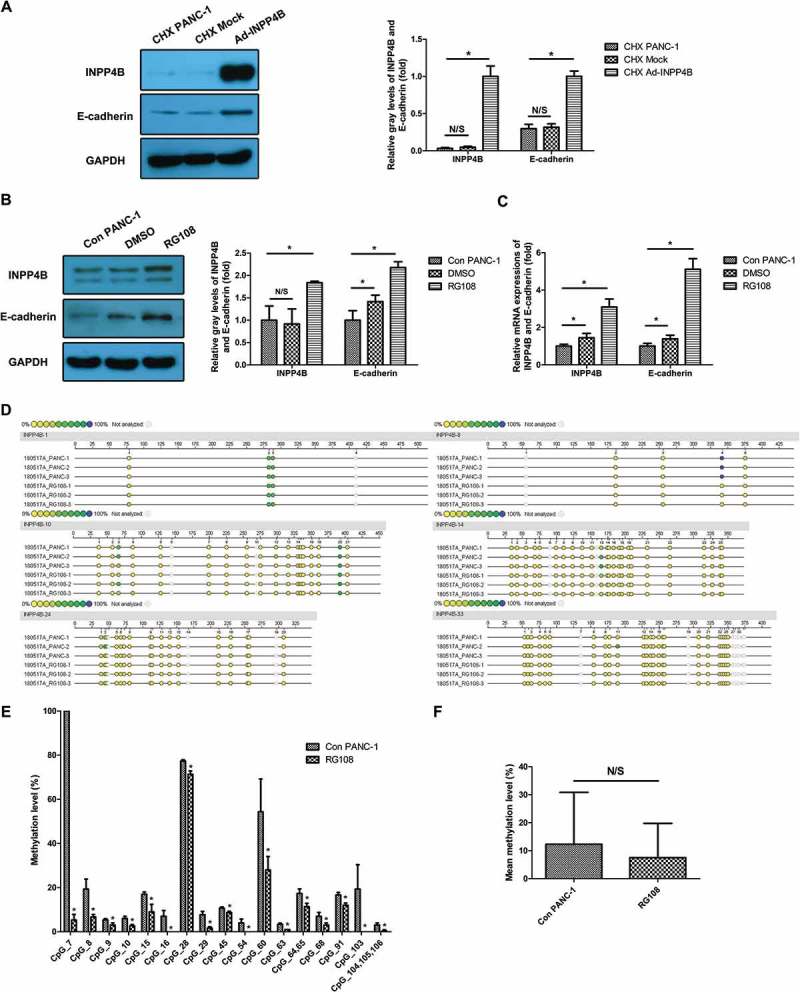
Chemicals treatment of PANC-1(a) PANC-1 cells overexpressing INPP4B were incubated in RPMI containing CHX and lysed for western blotting detection of Ecad and INPP4B. Mock infected and uninfected cells were parallelly treated with CHX and served as controls. (b, c) PANC-1 cells infected by Ad-INPP4B were treated with RG108 and probed for Ecad and INPP4B by western blot and RT-qPCR. DMSO-treated and untreated cells served as controls. The quantitative results of western blot and PCR were analyzed basing on gray-level ratio of target band and 2-△△Ct method. GAPDH was used as housekeeping gene for all data normalization. (d) Sequenom MassARRAY platform was used for the quantitative methylation analysis. The colors of each circle represent the methylation level of each corresponding CpG unit. Quantitative methylation analysis results are shown in a color scale: yellow (0% methylation), green (50% methylation), and dark blue (100% methylation). The white circles represent the missing data at a given CpG site. (e) The significantly changed methylation levels of certain CpG units were shown. (f) Mean methylation percentage of total CpG sites evaluated in the control group and RG108 group was compared. Results show mean ± SD (n = 3). N/S and * indicate P > 0.05 and P < 0.05.